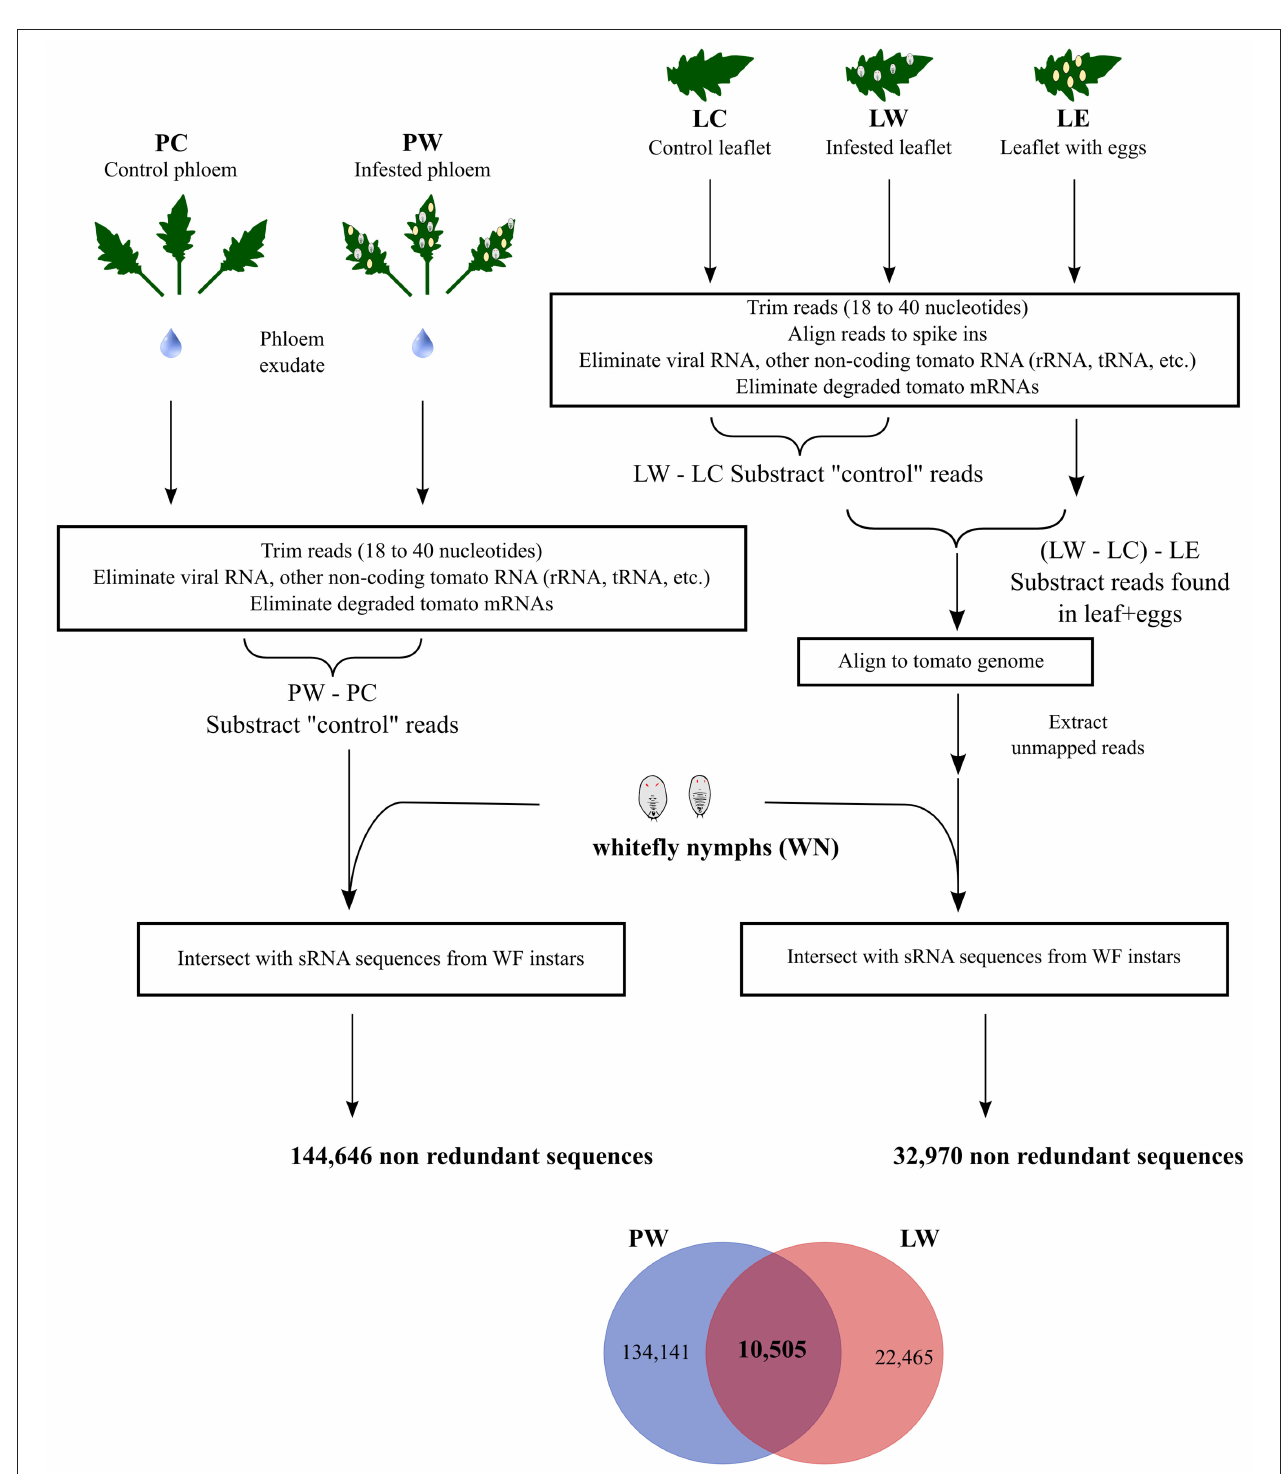
FIGURE 1 | Bioinformatic pipeline. Small RNAs (sRNAs) were isolated from tomato-phloem exudates from either control leaflets (PC) or leaflets infested with whitefly nymphs (PW), and from control tomato leaflets (LC), whitefly nymphs (WN), leaflets first infested with whiteflies but with adults and nymphs subsequently removed (LW) and tomato leaflets with only eggs (LE). A bioinformatic workflow (see main text for details) was implemented yielding 10,505 non-redundant small RNAs present in feeding whitefly nymphs plus identified in both infested tomato phloem and leaflets.